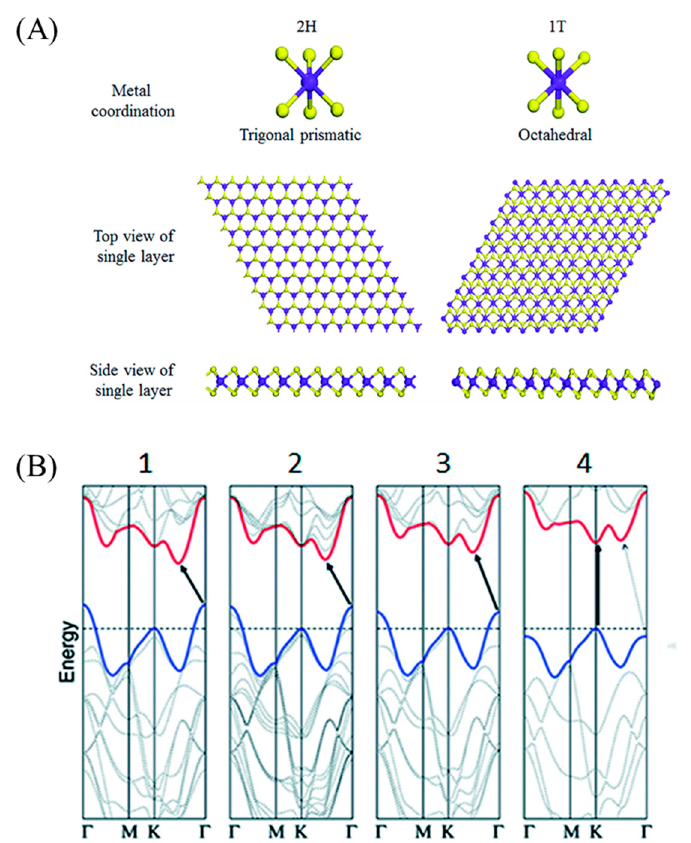
Figure 1. ( A ) Metal coordination, top view, and side view of single-layer 2H-MoS 2 and 1T-MoS 2 . Reproduced with permission from [44] Copyright © 2021 The Royal Society of Chemistry. ( B ) Energy dispersion (energy versus wavevector k) in ( 1 ) bulk, ( 2 ) quadrilayer, ( 3 ) bilayer, and ( 4 ) monolayer MoS 2 from left to right. Reproduced with permission from [48] Copyright © 2021 The American Chemical Society.